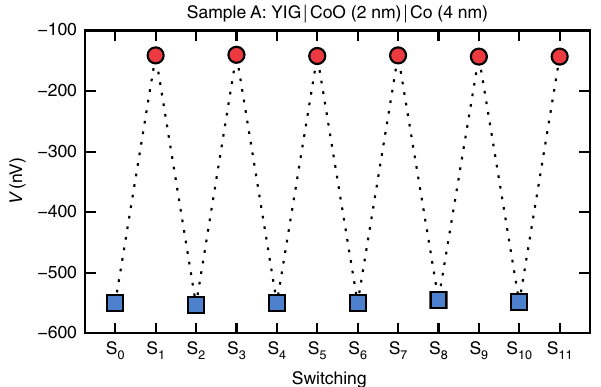
Fig. 4 Alternating voltage levels by switching the Co magnetization. Total voltage for parallel (red circles) and antiparallel (blue squares) alignment of Y 3 Fe 5 O 12 (YIG) and Co measured in sample A at ferromagnetic resonance H YIG ¼ 788 Oe at T = 120 K. The presented sequence Si corresponds to the FMR magnetization of the Co layer being switched repeatedly by driving the external fi eld above (below) the Co coercive fi eld H þ H (cid:2) ¼ (cid:2) 970 Oe ). The absolute voltage difference is (408 ± 5) nV and the c relative change amounts to (290 ± 4)